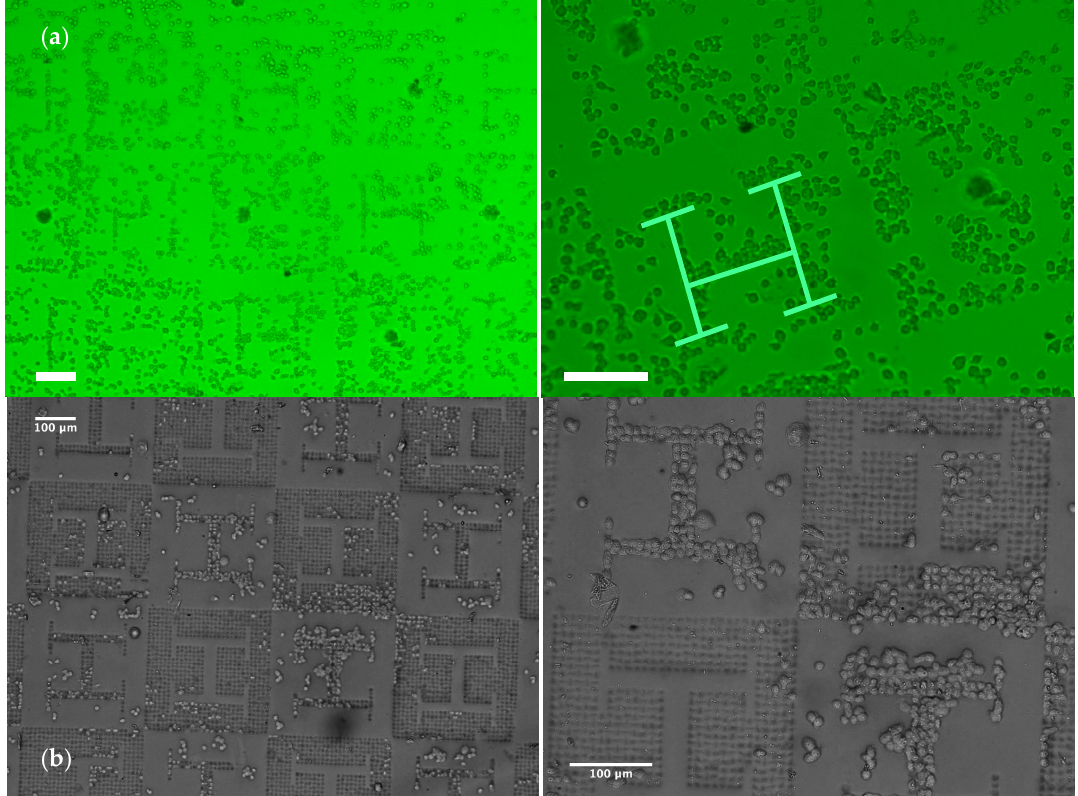
Figure 3. Results from Dictyostelium discoideum culture processes, performed upon different replicas of the polyacrylamide substrates obtained by soft-lithography: ( a ) MEIJI TC5400 optical microscope with phase contrast, ( b ) Leica EZ4HD stereoscopic microscope. Visual inspection shows how cells are organized due to the presence of topographical transitions. H-like cell patterns can be perceived in regions, where the transferred microwells create a vascular pattern; while larger cell clusters can be seen in regions, in which microwells surround planar vascular-like zones. White scale bars = 100 µm.